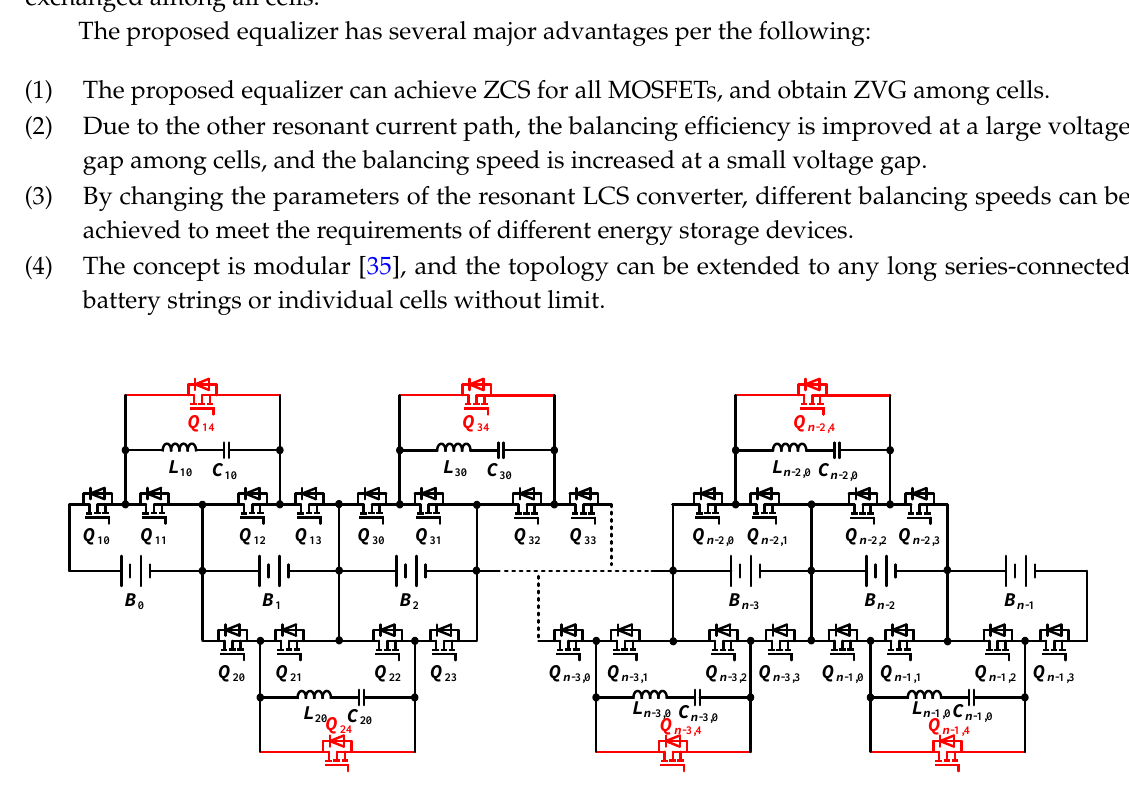
Figure 2. Schematic diagram of the proposed system for n series-connected battery cells.